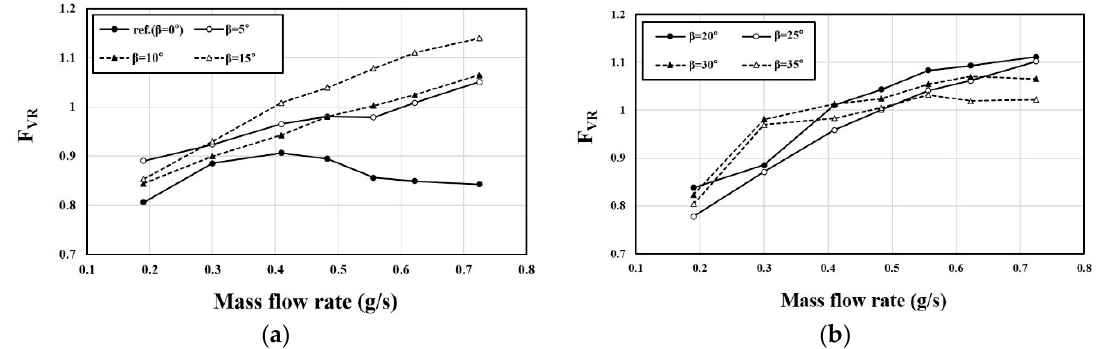
Figure 10. Variations of peak velocity ratio with mass flow rate for various bending angles. ( a ) in the case of the reference model ( β = 0) and ( b ) in the case of β = 20°, 25°, 30° and 35°.